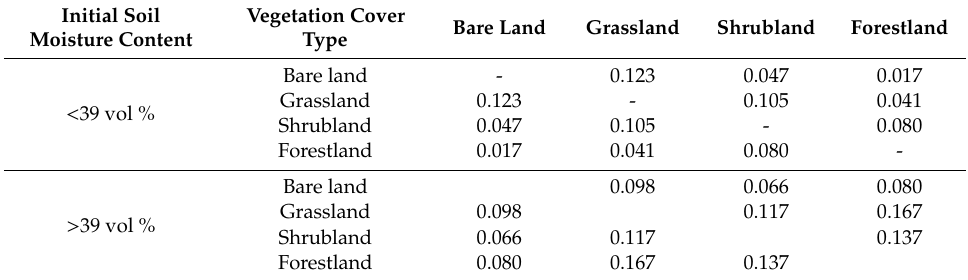
Table 7. Comparison of peak volumetric soil moisture times under di ff erent vegetation cover types based on the Mann–Whitney’s U test with Bonferroni correction ( p -value).